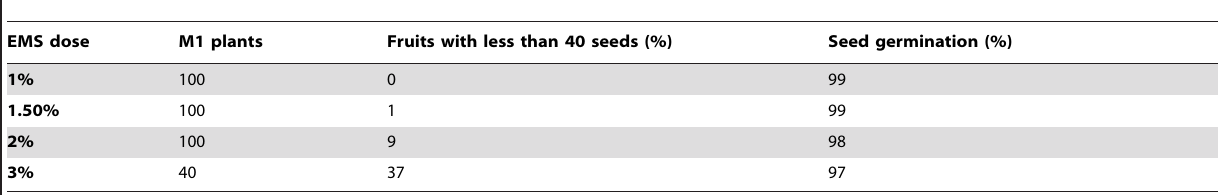
Table 1. Impact of EMS concentration on M2 seed setting and